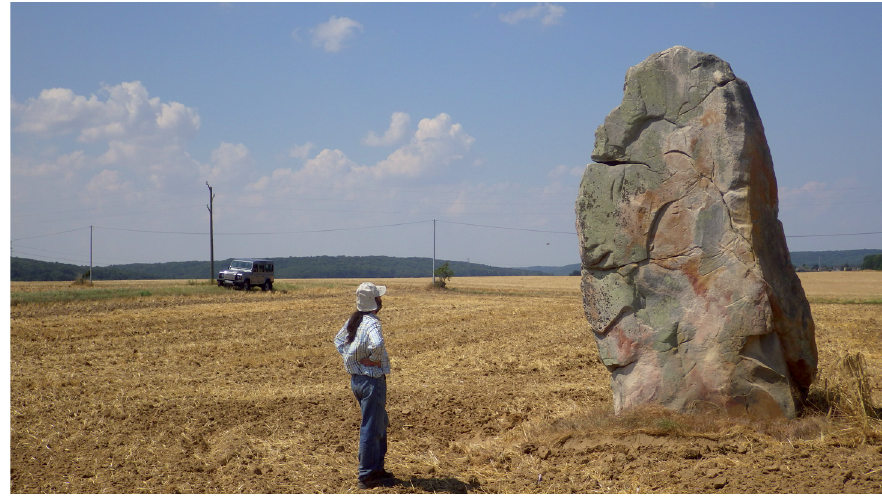
Figure 11. The Roche à Gentil menhir in Itteville (Essonne). © J. Bruant/Inrap.